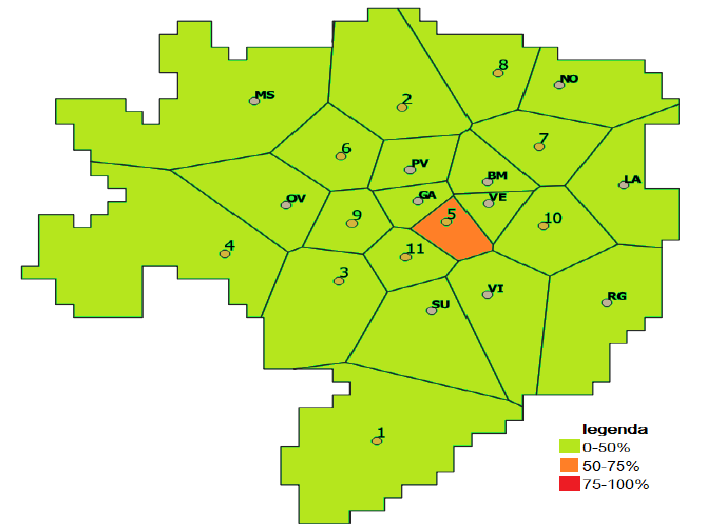
Figure 26. PSs service areas considering eleven incremental PS. The colors report the power demand outside the PS transformers ’ nominal power.